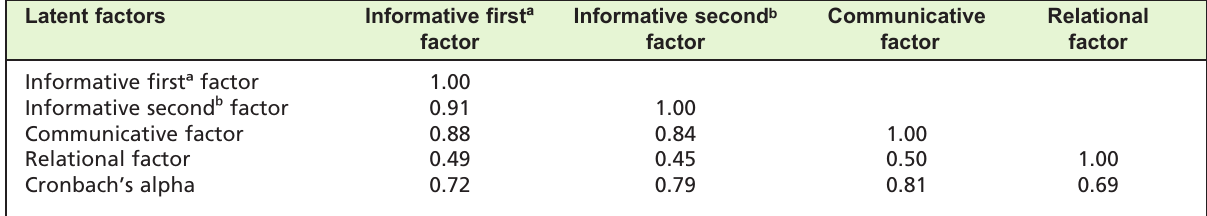
Table I: Confirmatory factor analysis of internal consistency coefficients